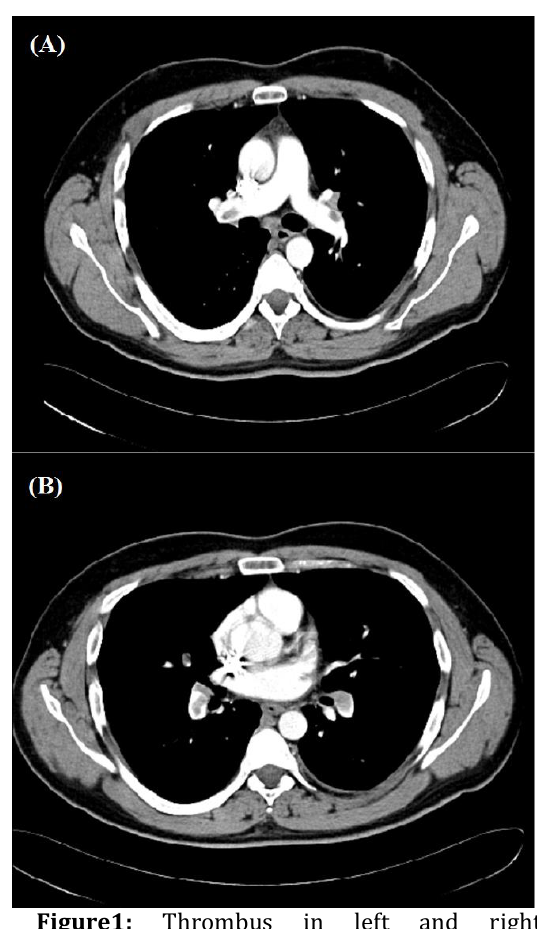
Figure1: Thrombus in left and right pulmonary artery